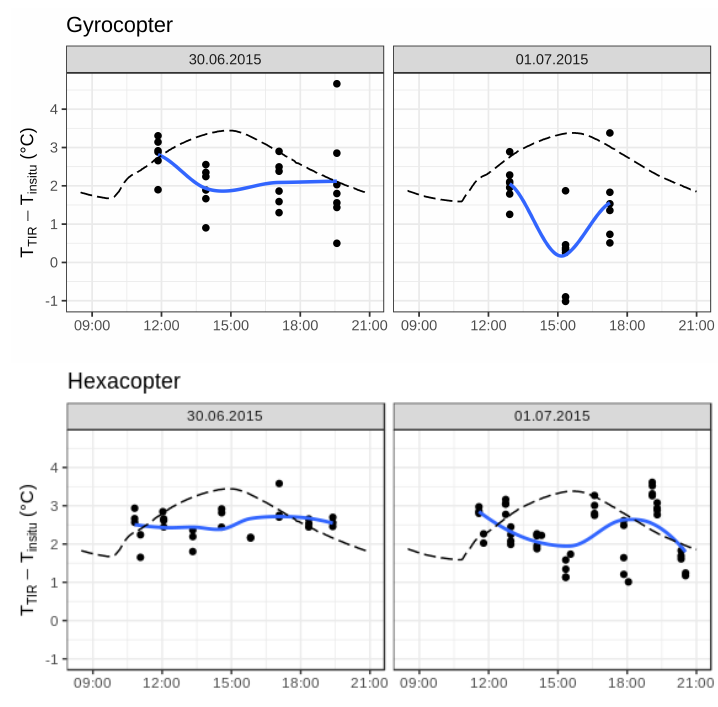
Figure 4. The temperature difference between uncorrected TIR temperatures ( T TIR ) and in situ measurements ( T insitu ) for all flights (solid circles), the smoothed difference (LOESS smoothing, solid blue line), and water level (cm/200, dashed